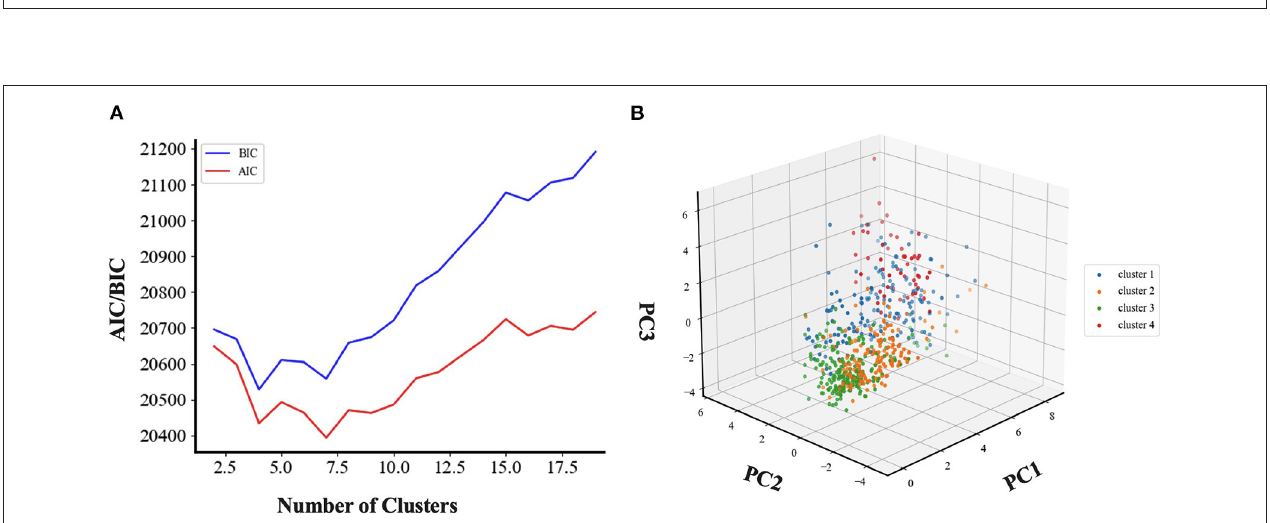
FIGURE 4 | Model selection and cluster visualization. The selection of the best number of clusters K is based on BIC and AIC score. K = 4 was chosen after comparing the BIC score of models with different number of clusters by unsupervised clustering analysis. For AIC score, K = 4 is also a good choice for the trade-off between model complexity and the fitting of the data. (A) Unsupervised clustering analysis for choosing the best number of clusters. BIC, Bayesian information criteria; AIC, Akaike information criterion. (B) Three-dimensional visualization of clustering results. We visualize our clustering results in three-dimensional space. The high dimensional training data was projected into three-dimensional space by using principal component analysis. PC, Principal component.